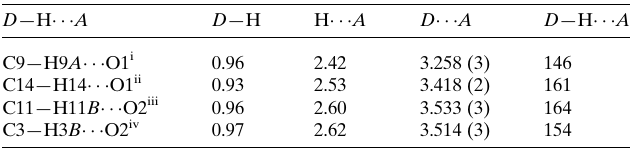
Table 1 Hydrogen-bond geometry (A˚ , (cid:2) ).